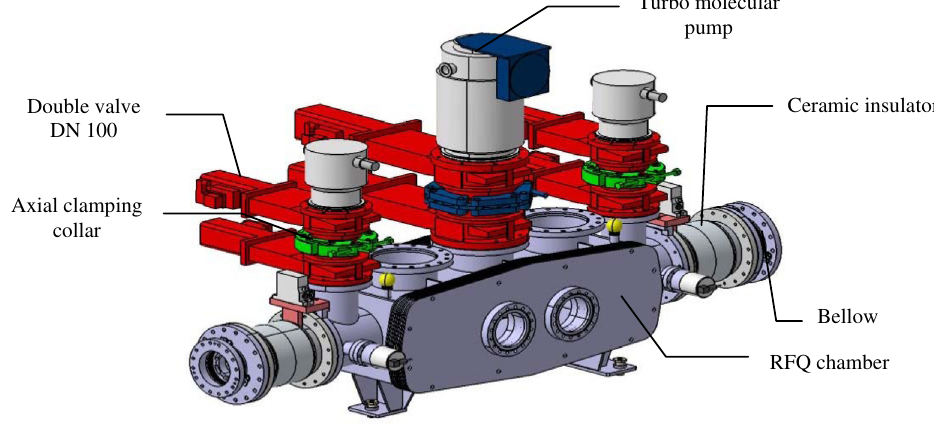
FIG. 12. Protection process of the turbomolecular pumps from radioactive gaseous waste.